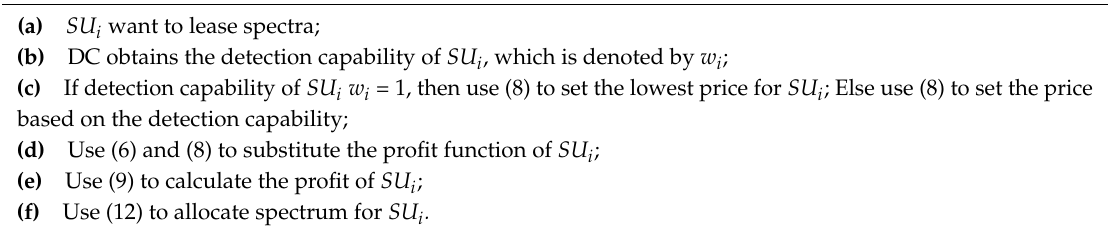
Algorithm 1 : Given that there is one PU system (including one DC and some PUs) and some SUs ( SU i , i = 1 to N ) in a region grid of the MCRCS. If PUs have free spectra. For i = 1 to N , do steps